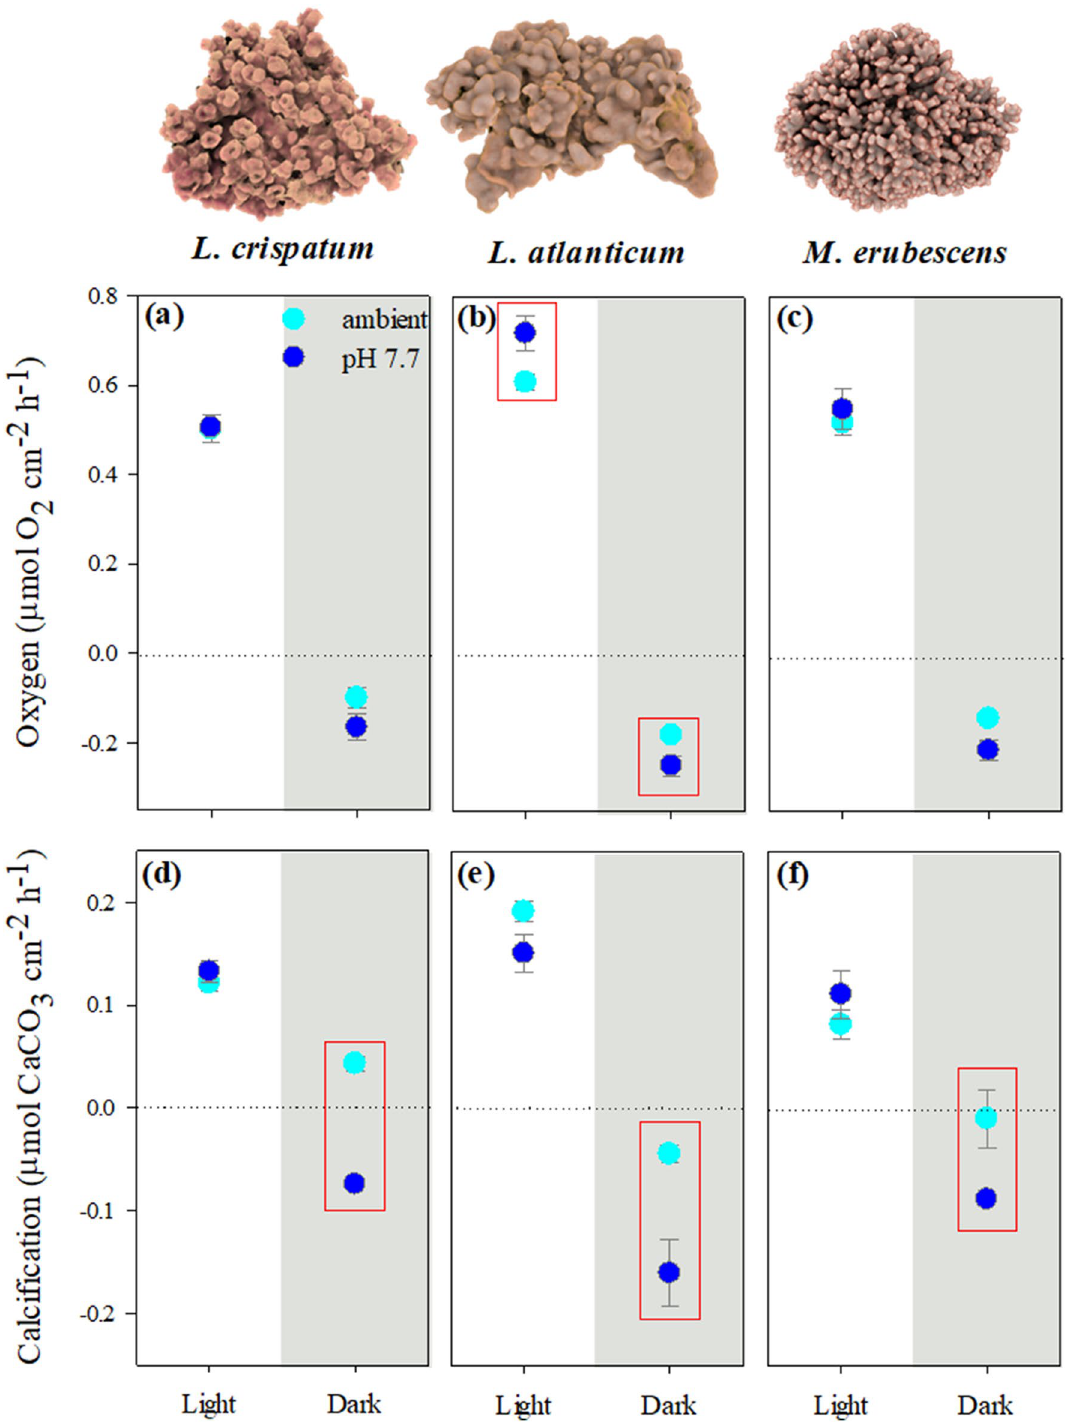
Figure 6. Rhodolith metabolic and calcification responses to ambient and low seawater pH. ( a – c ) Maximum gross photosynthesis and dark respiration and ( d – f ) light and dark calcification rates. Data are shown as mean ± SE (n = 5) and red boxes indicate significant differences between the two pH conditions (ANOVA, Newman Keuls, p <